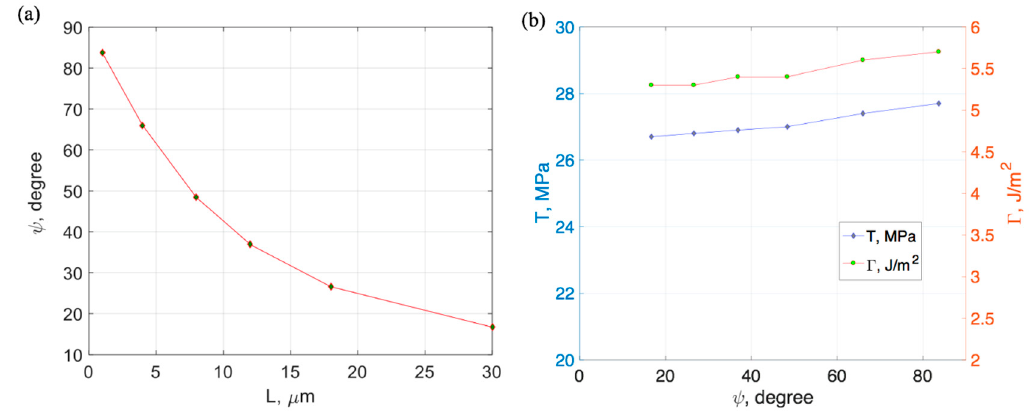
Figure 9. ( a ) Phase angle versus beam length, ( b ) vectorial fracture strength and toughness versus phase angle.